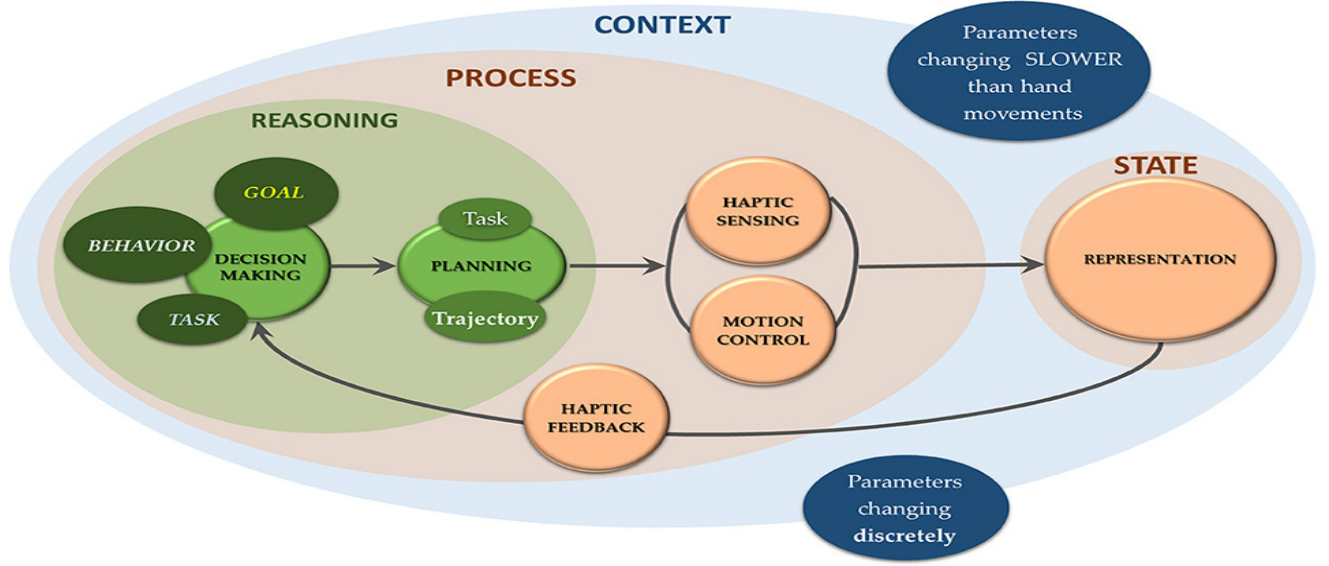
Figure 7. Closed-loop robot control of the sensorimotor type [63].